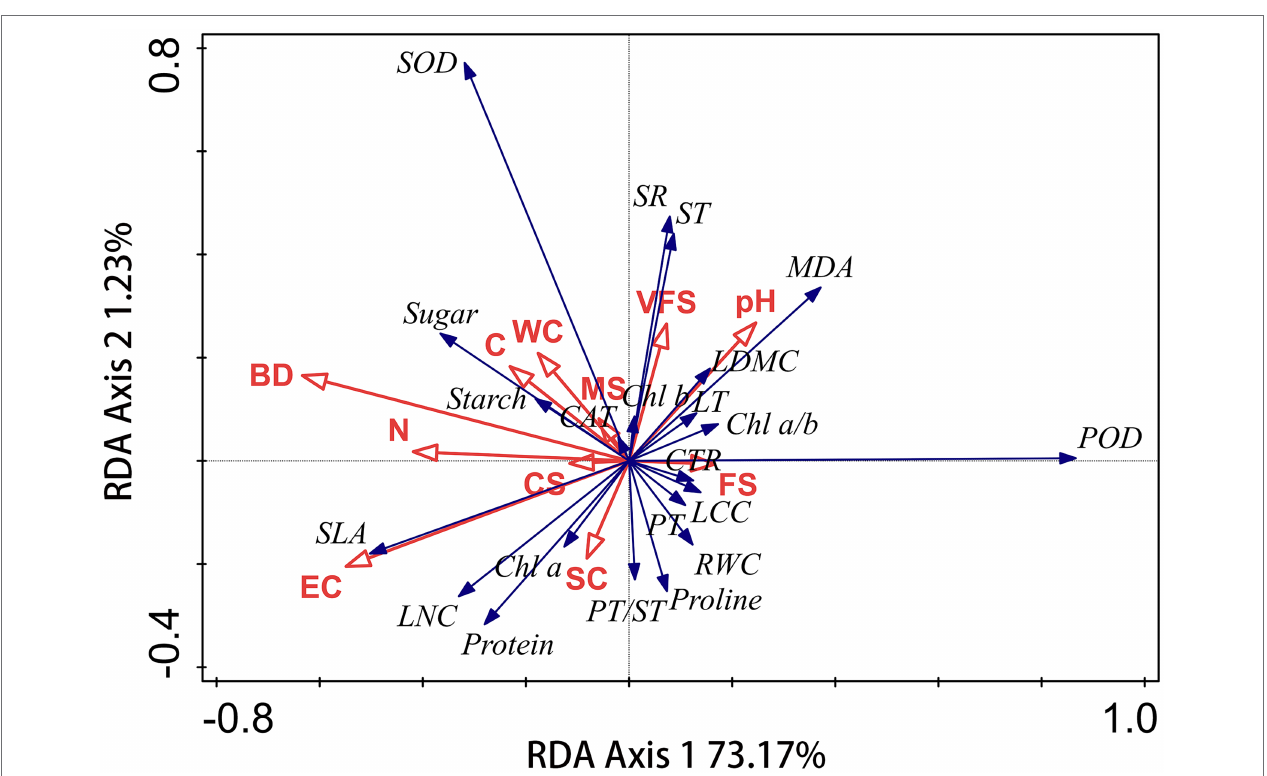
FIGURE 7 | Redundancy analysis (RDA) identifying the effects of soil properties on leaf traits of S. glareosa . WC, water content; EC, electrical conductivity; BD, bulk density; CS, coarse sand; MS, medium sand; FS, fine sand; VFS, very fine sand; and SC, silt and clay.